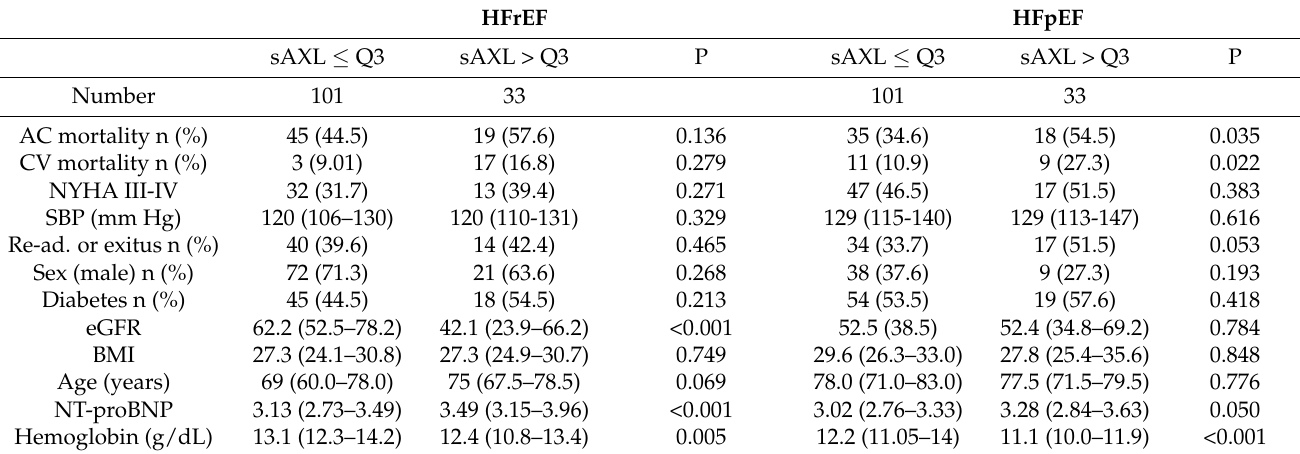
Table 4. Heart failure patients’ characteristics according to the sAXL